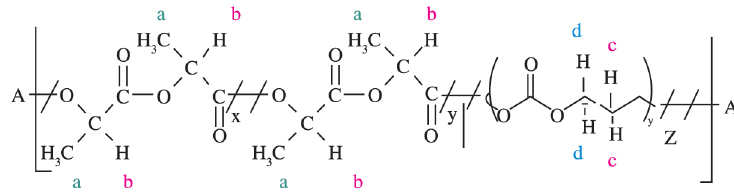
Figure 1. Hydrogen residues corresponding to L-lactide, D,L-lactide and TMC.